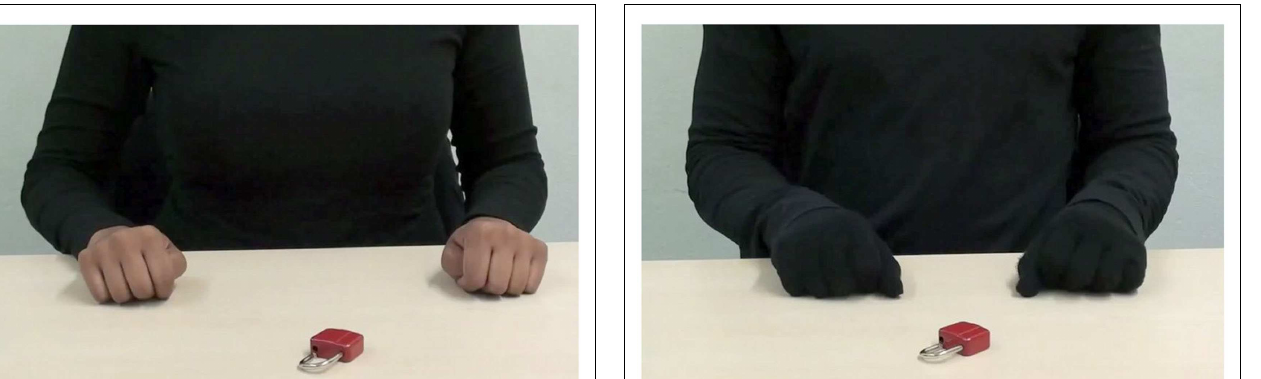
FIGURE 3 | Screenshot of action video Unlock the lock! presented in the control